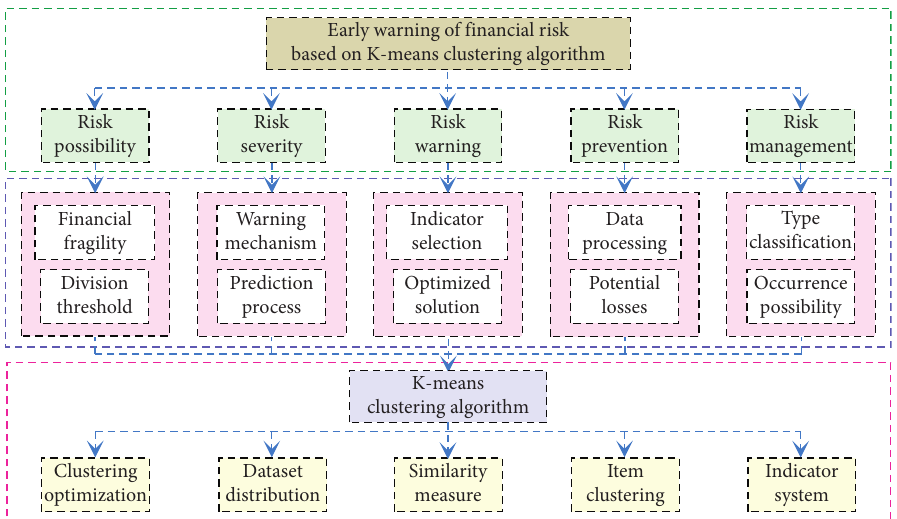
Figure 1: Framework of financial risk early-warning based on K-means clustering algorithm.